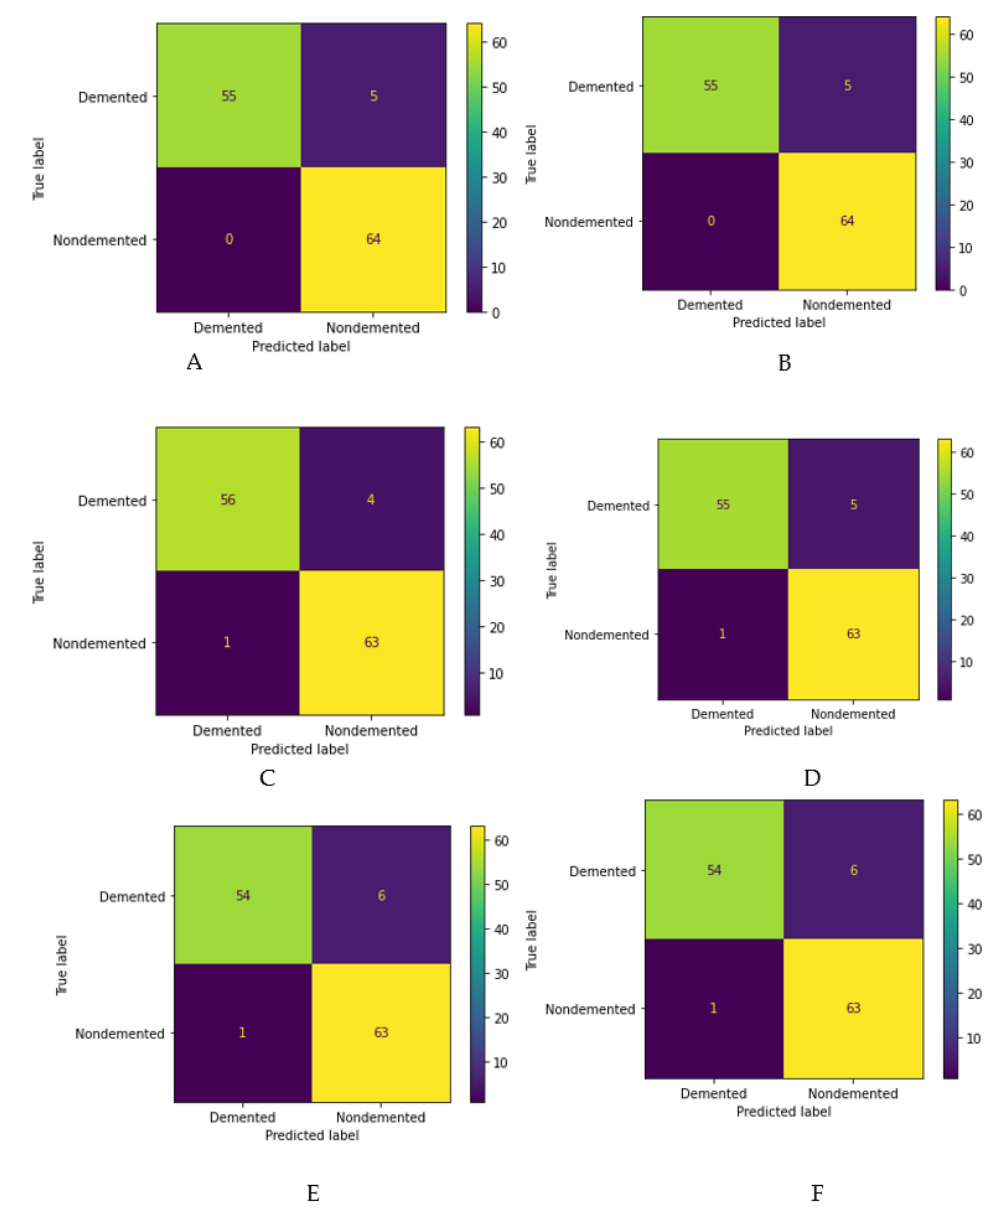
Figure 6. The confusion matrix outcomes of ( A ) Support vector machines ( B ) Logistic regression ( C ) Random Forest ( D ) Naïve Bayes ( E ) AdaBoosting ( F ) Gradient boosting.